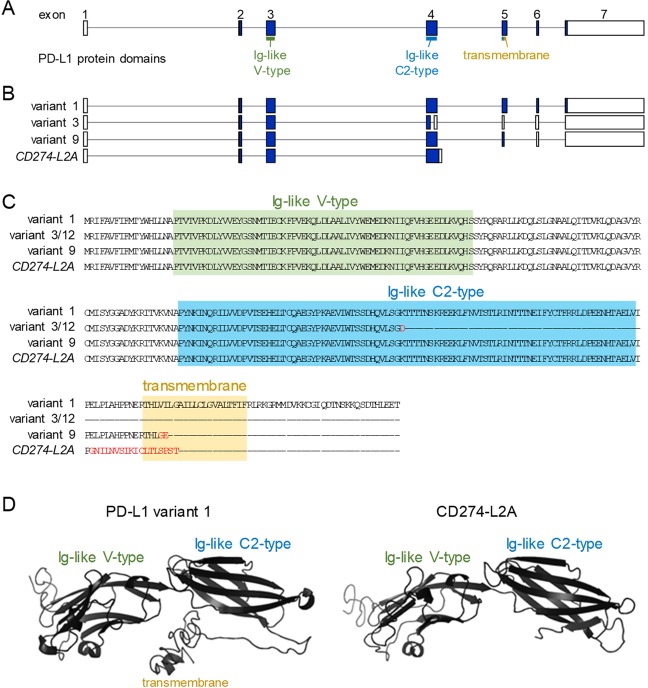
The CD274-L2A protein product retains receptor binding domains but not transmembrane domain.(A) CD274 exons encoding receptor binding and transmembrane domains. (B) Transcript structure of the full-length CD274 variant 1 and variants 3/12, nine and CD274-L2A lacking the transmembrane domain. (C) Amino acid sequence of the same variants as in B. Amino acid residues differing from the index sequence are indicated in red. (D) Modelled structure of full-length CD274 variant one and truncated variant CD274-L2A, illustrating the receptor binding and transmembrane domains.